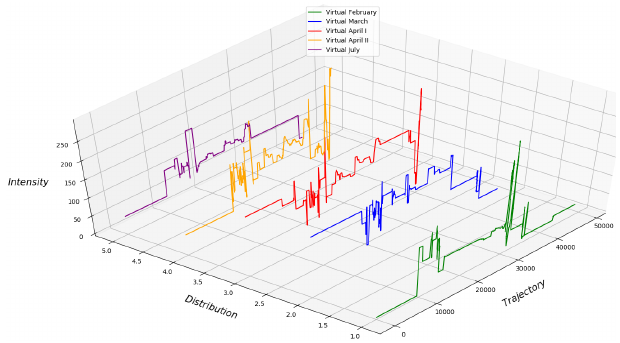
Figure 7. Unique light segments between Γ SL=30 and ρ